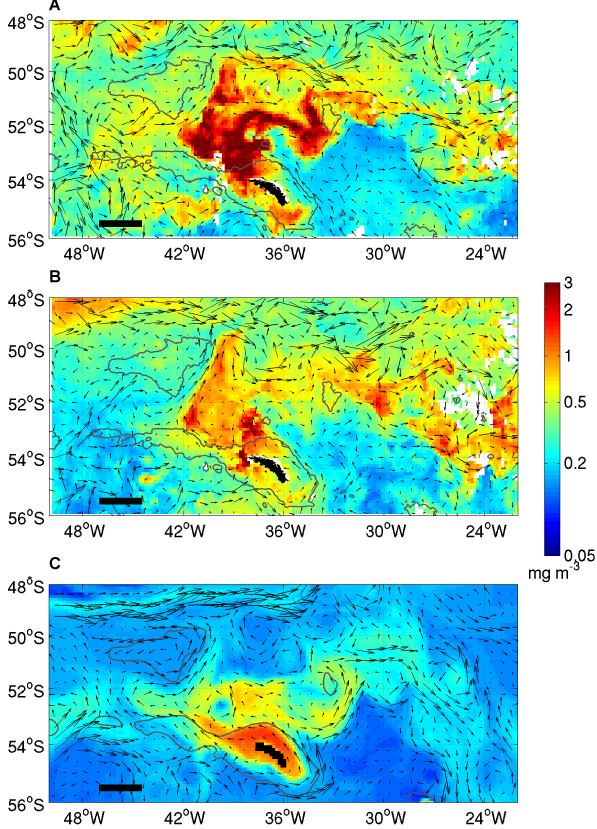
Fig. 6. Surface Chl a concentrations in the South Georgia area as obtained from MODIS ocean colour estimates for January– February 2008 (A) and January–February 2011 (B) . Satellite es- timates are interpolated onto the model’s coarser grid resolution. In (C) surface (0–30m) averages of Chl a concentrations from January–February of the last modelling year. In all cases, black arrows depict contemporaneous surface circulation patterns either from Aviso altimetry (in A and B ) or from the model (in C ). Circu- lation patterns in panels A and C are equivalent to those depicted in Fig. 4. In all panels, the 2000m bathymetry is indicated with thin lines; the horizontal bar in the bottom-left corner indicates 1ms − 1 , and corresponds to approximately